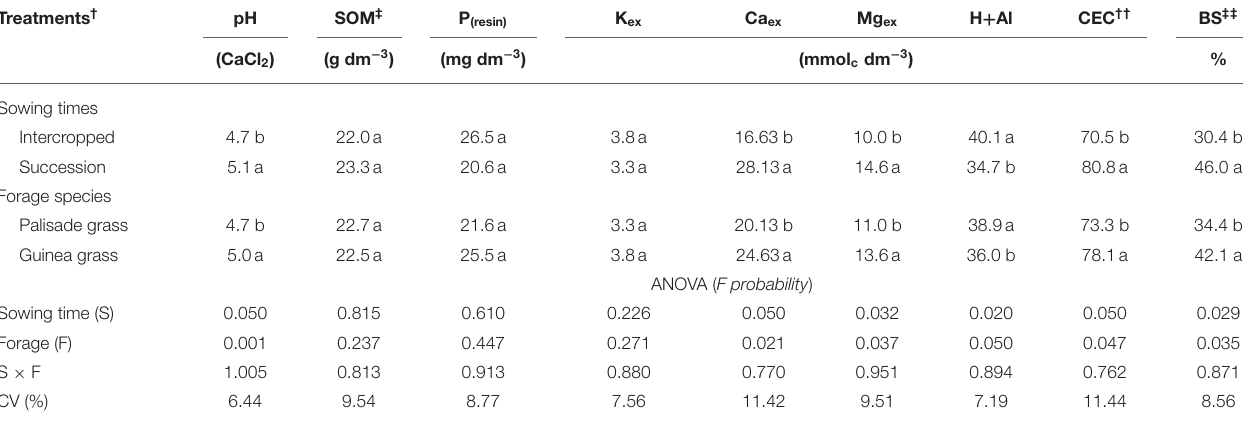
TABLE 5 | Soil chemical characteristics of the experimental site at 0–0.20m depth after soybean harvest. Treatments